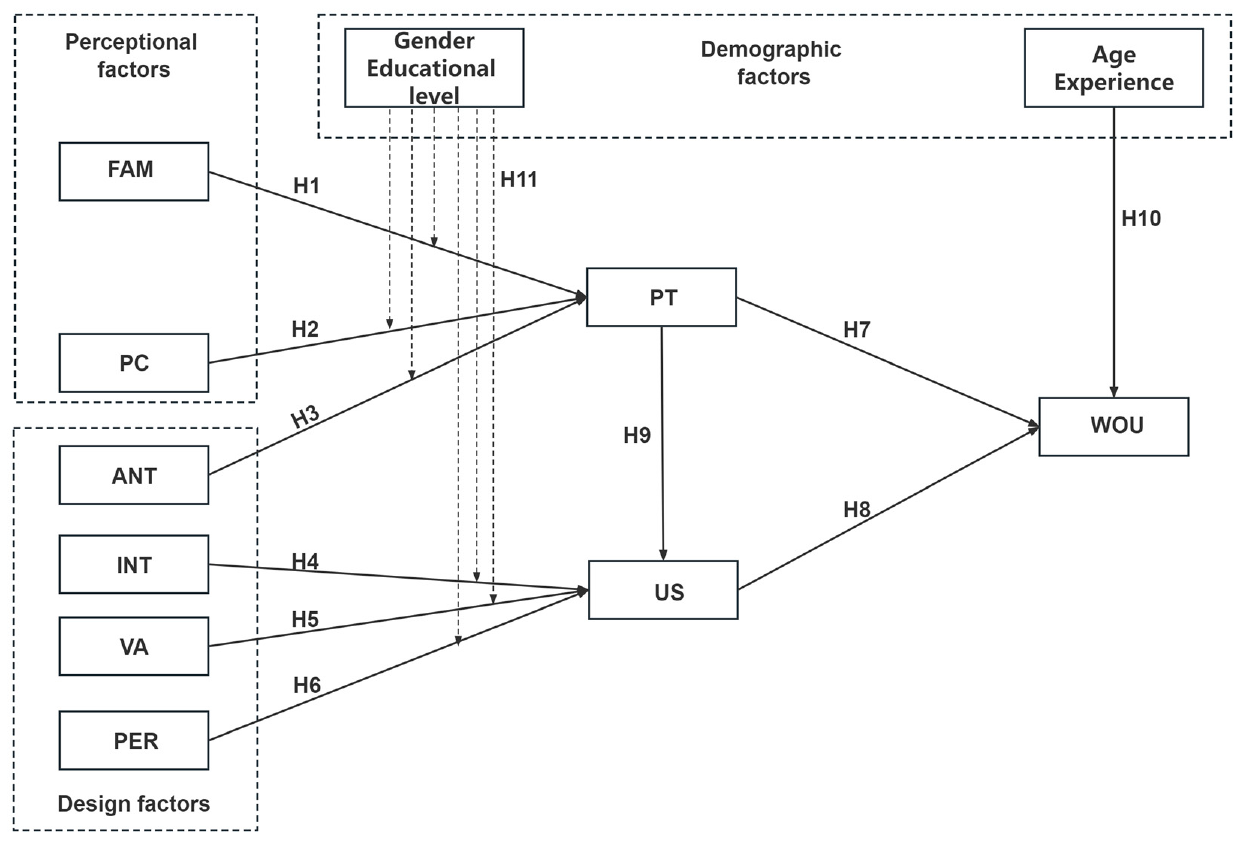
Figure 1. Theoretical model.